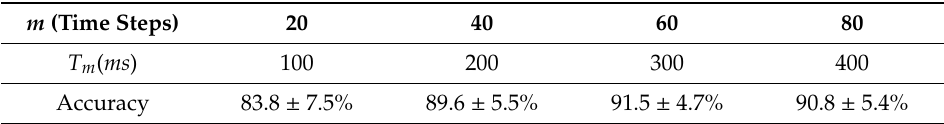
Table 2. Prediction accuracy with di ff erent m